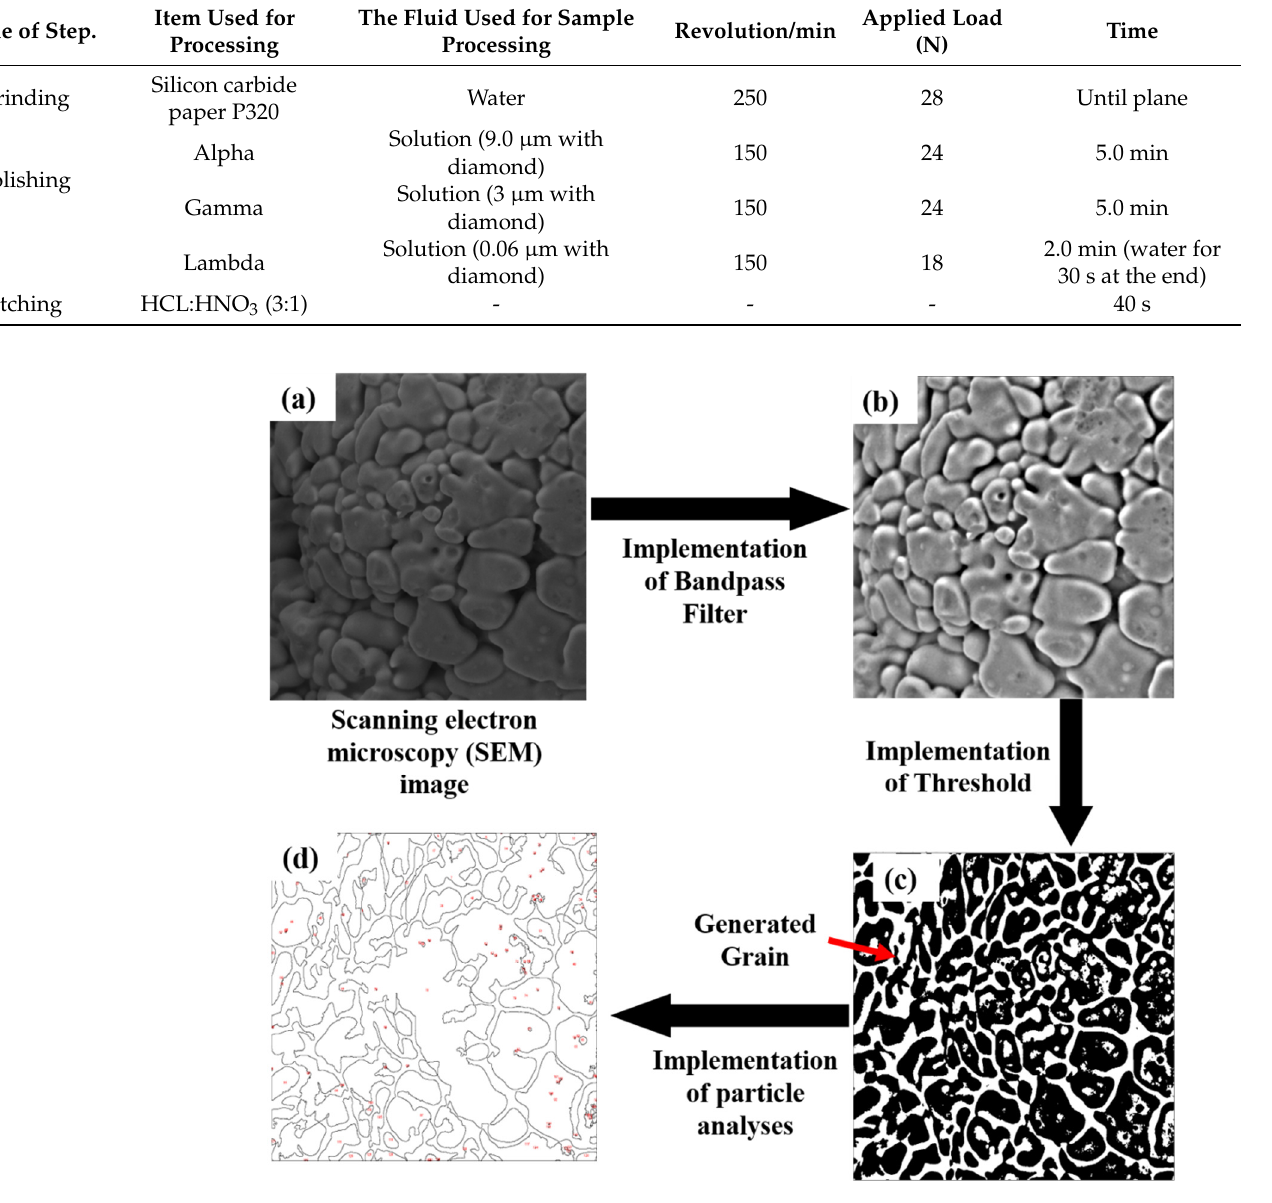
Figure 5. Implementation of “Image ‐ J” software to calculate the average dendrite grain size in a SEM image ( a ) SEM image, ( b ) image after implementing bandpass filter, ( c ) image after implementing threshold filter, and ( d ) image achieved after particle analyses.